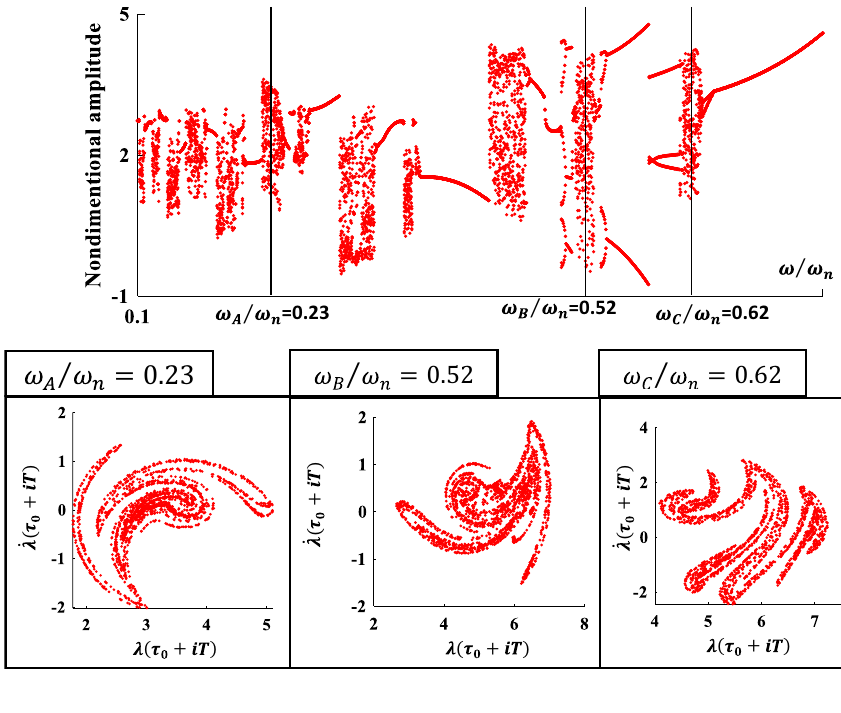
Fig. 7 Bifurcation and cor- responding Poincaré map for = n f